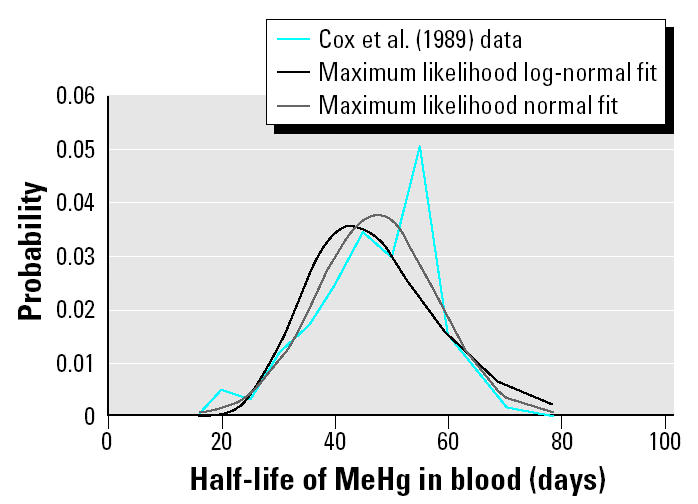
Comparison of Cox et al. (1989) half-life data to maximum likelihood normal and log-normal distributions.